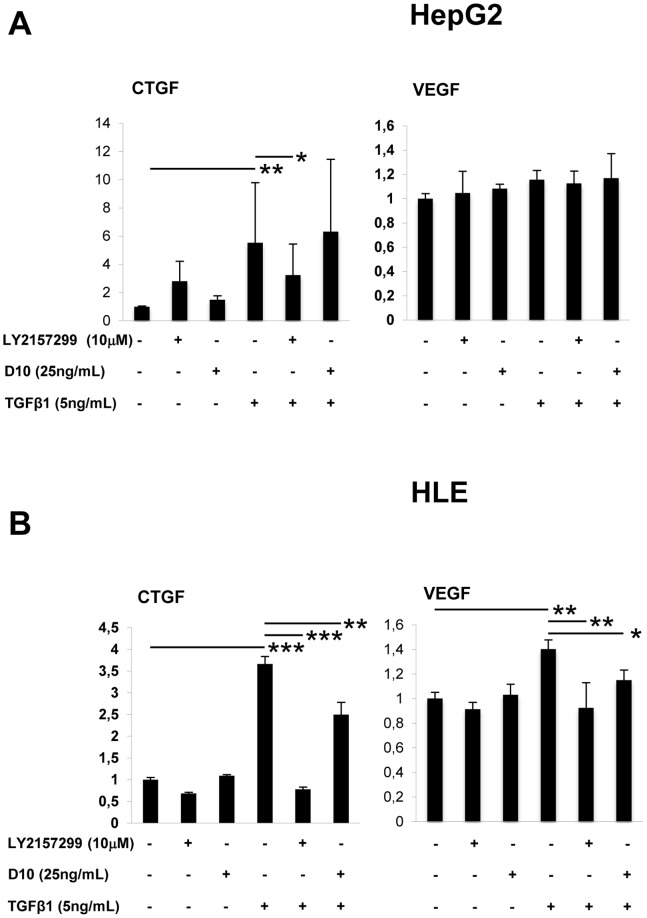
Effect of LY2157299 and D10 on CTGF and VEGF gene expression in HCC cell lines.(A) HepG2 and (B) HLE cells were preincubated with LY2157299 (10 µM) or D10 (25 ng/mL) and then stimulated with TGF-β1 (5 ng/mL) in the presence or absence of LY2157299 or D10. After 48 hours, RNA was extracted and real-time PCR was performed. Values are expressed as relative gene expression versus GAPDH and represent the mean ±SD of three independent experiments. *P<0.05, **P<0.01, ***P<0.001.